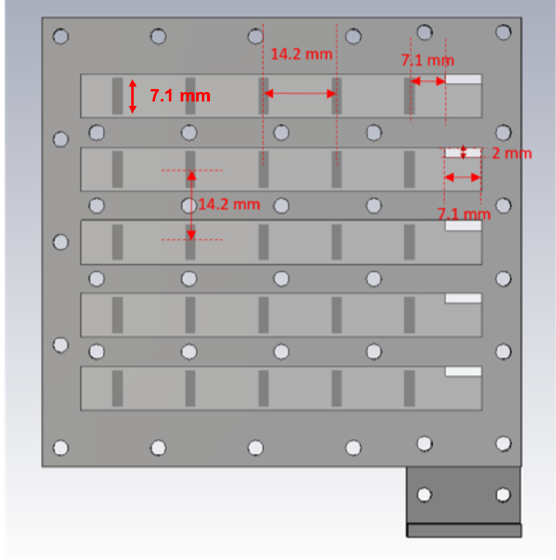
Figure 3. Interior of the radiating